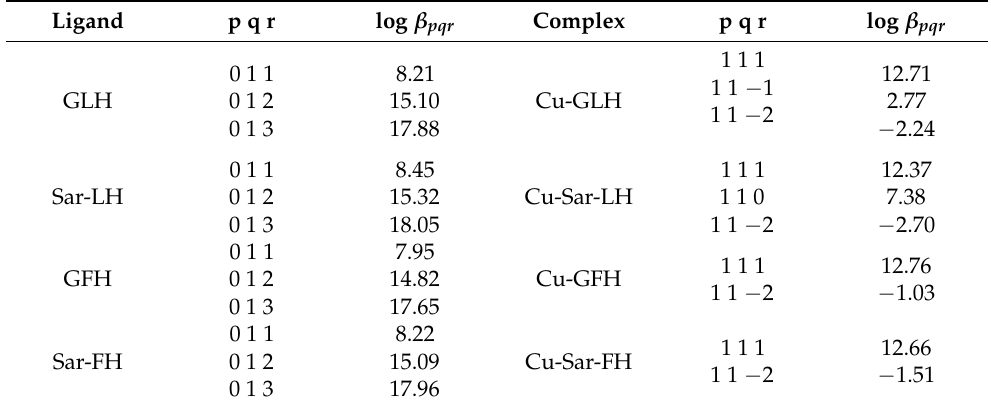
Table 1. Protonation and stability constants of GLH, Sar-LH, GFH and Sar-FH with